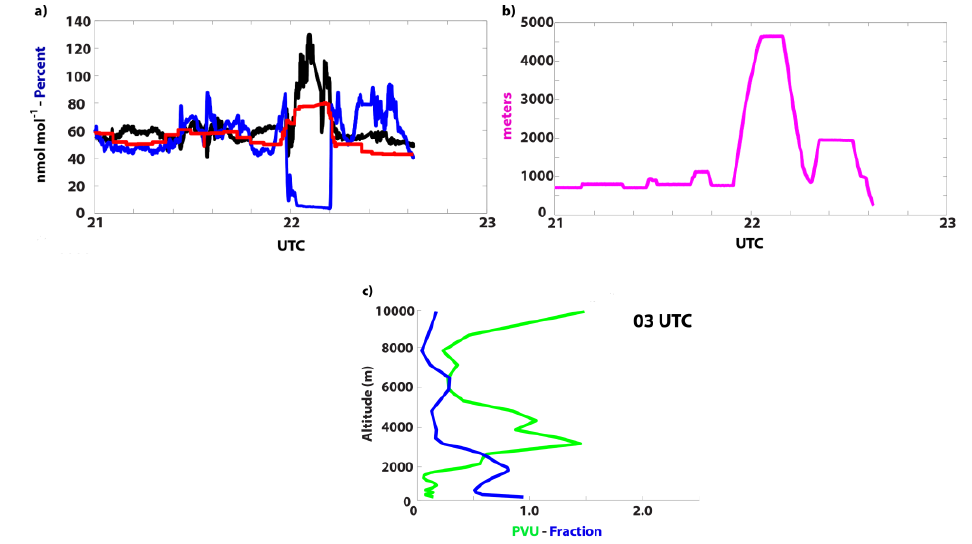
Figure 8. Information supporting the influence of stratospheric air on tropospheric O 3 on 29 June 2013 from ( a ) P3 measured O 3 (black line, nmol mol − 1 ), RH (blue line, %), and GEOS-Chem-predicted O 3 (red line, nmol mol − 1 ); ( b ) P3 measured altitude (meters); and ( c ) GEOS-5 simulated PVU (green line, PVU) and RH (blue line, fraction) at 03 UTC.